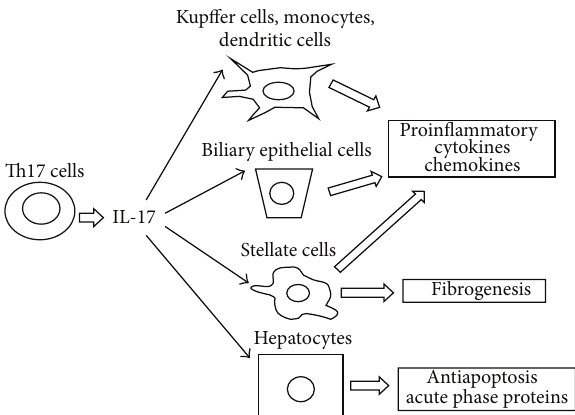
Figure 2: IL-17 plays a role in the pathogenesis of liver diseases. IL- 17 stimulates multiple types of liver nonparenchymal cells to secrete proinflammatory cytokines and chemokines, thereby inducing and promoting liver inflammation. IL-17 alsopromotes liver fibrogenesis by hepatic stellate cell activation. In addition, IL-17 may stimulate hepatocytes to produce C-reactive proteins and promote hepatocyte